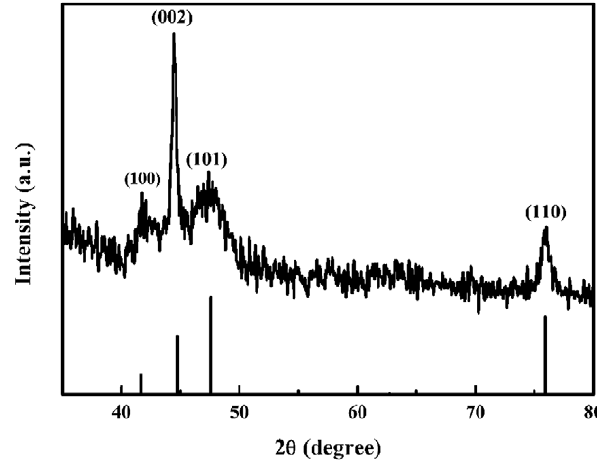
Figure 2. XRD pattern of chain-like Co flower (upper) and standard diffraction pattern of Co (JCPDS Card No. 05-0727) (lower).